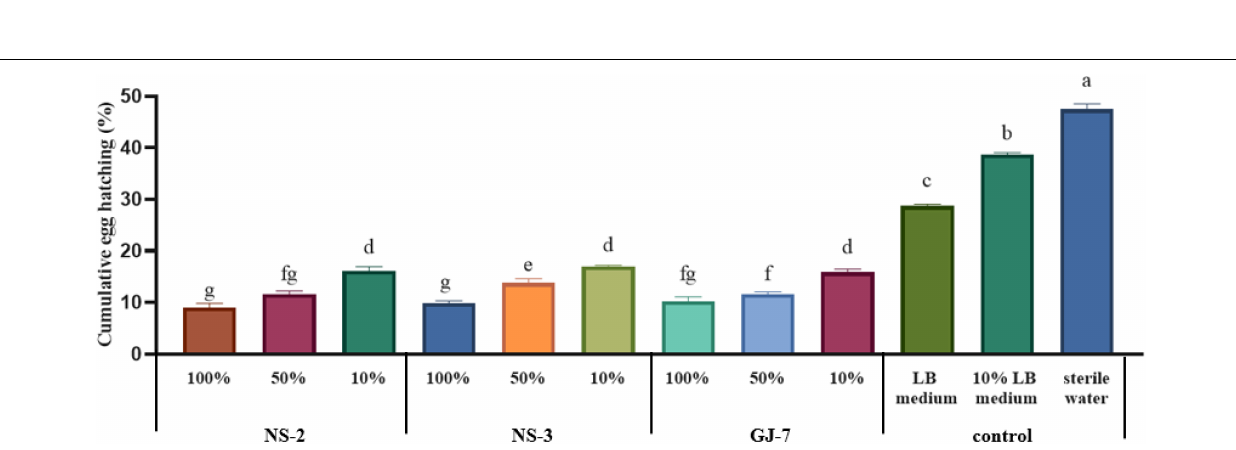
FIGURE 1 | The mortality rate of the second-stage juveniles (J2s) of Meloidogyne hapla induced by Bacillus cereus strain NS-2, Lysinibacillus strain NS-3, and Bacillus velezensis GJ-7 cell-free supernatant in vitro . Abamectin (1 µ g/ml), a strong biological nematicide, was used as a positive control, while LB medium, 10% LB medium, and sterilized water were used as negative controls. Data were analyzed by one-way ANOVA with Duncan’s multiple range test, and error bars represent the standard error of three biological and ten technical replicates ( n = 30). Different lowercase letters indicate significant differences among treatments ( P < 0.05).